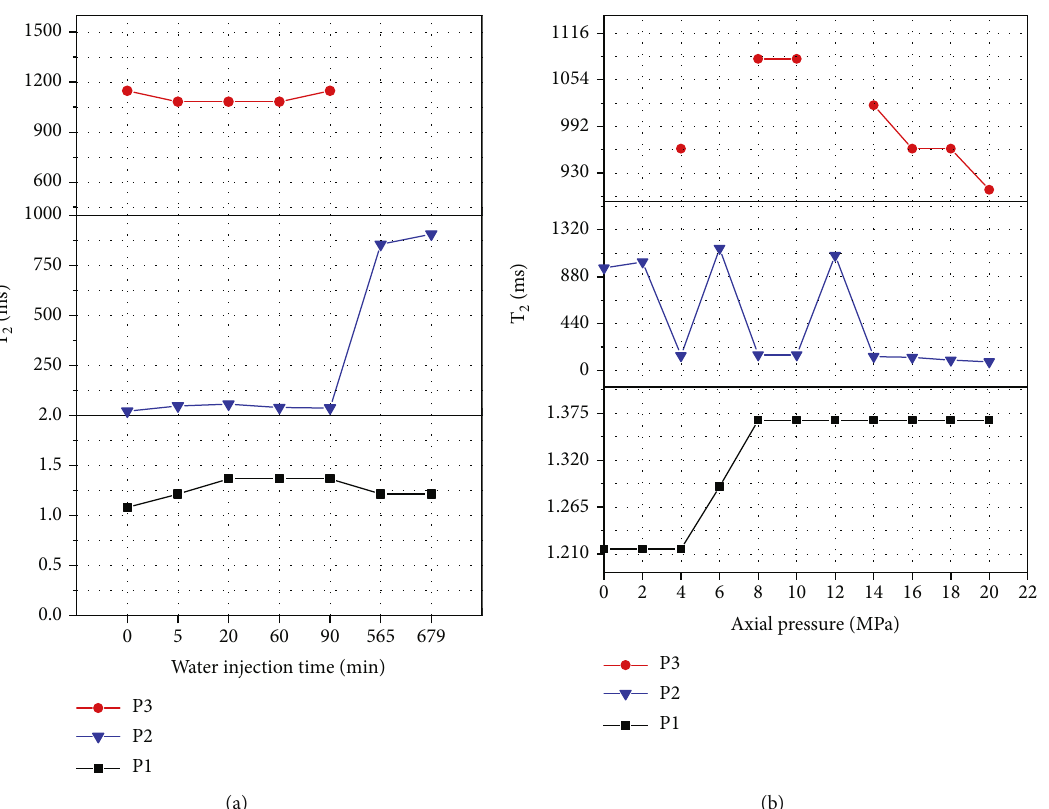
Figure 7: T 2 crest values of each peak. (a) Water injection process. (b) Triaxial compression process.